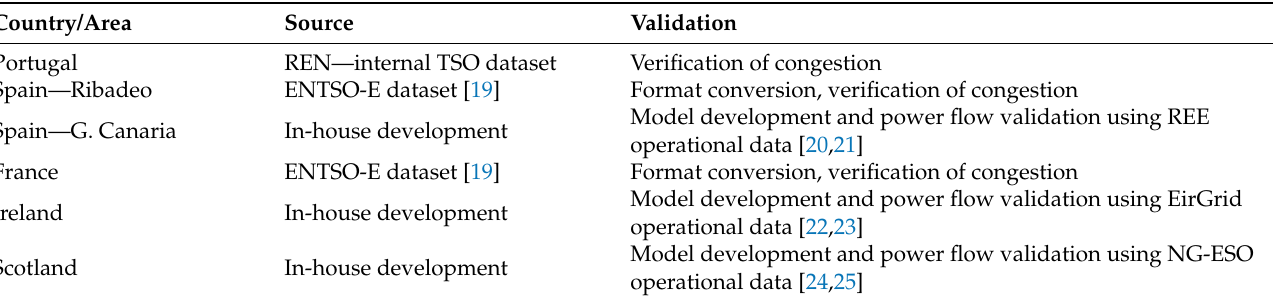
Table 2. Power system models considered in